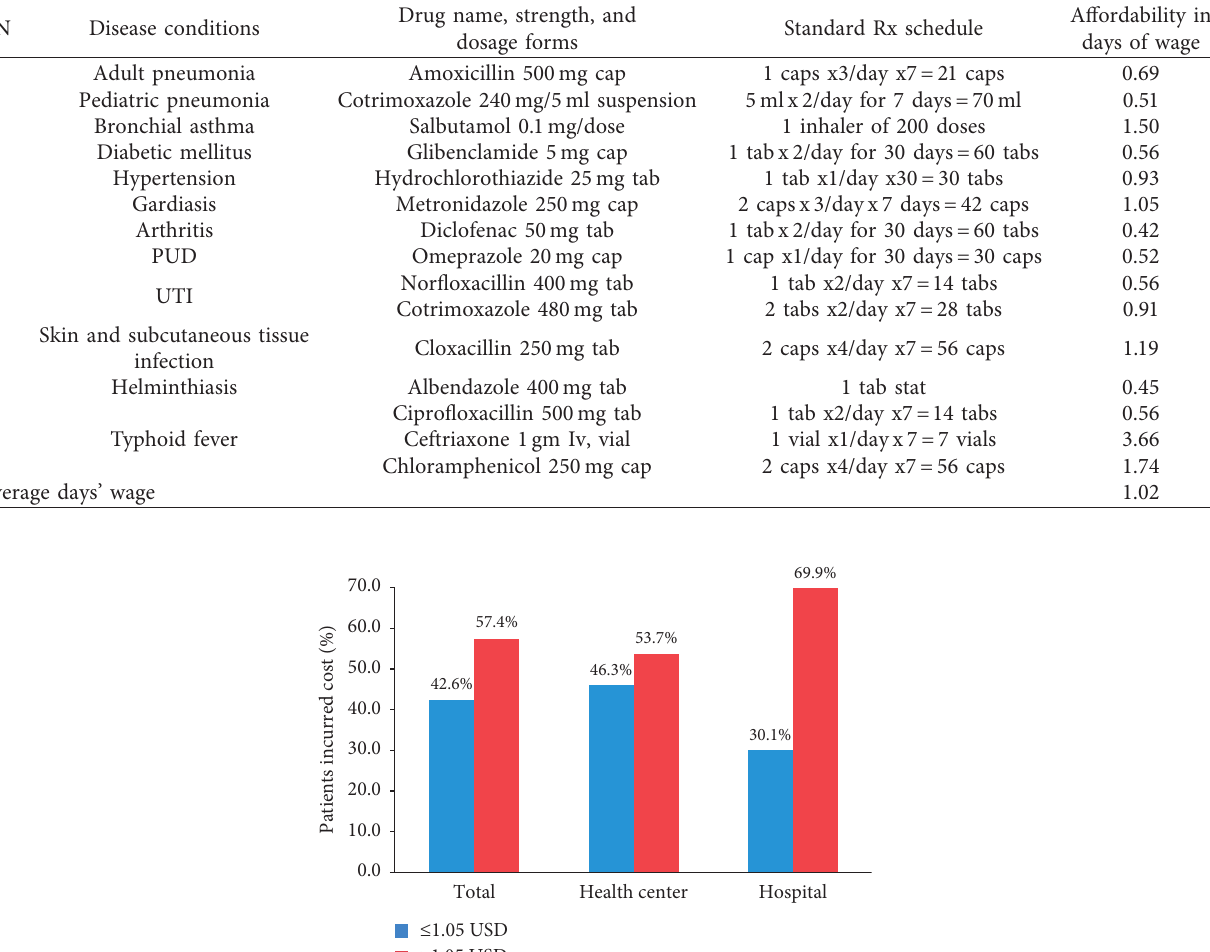
Table 2: Affordability of a single course of treatment in days’ wage of an LPGW for some disease conditions in Jimma Zone public health facilities, May 2018.